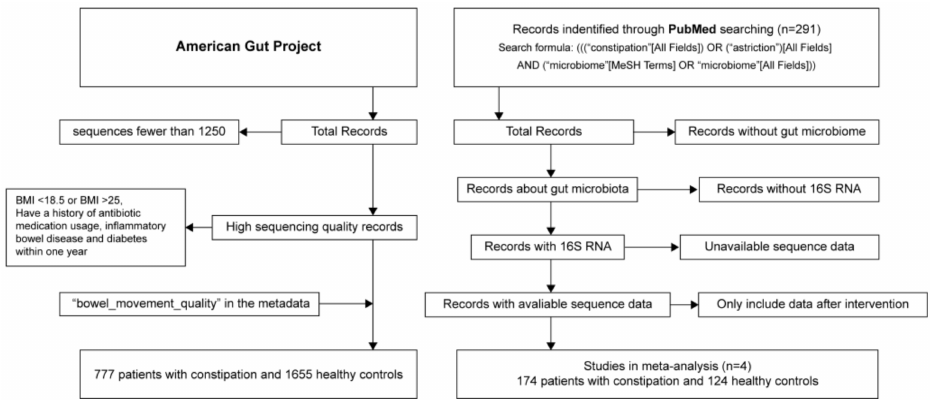
Figure 1. Search and selection of studies.